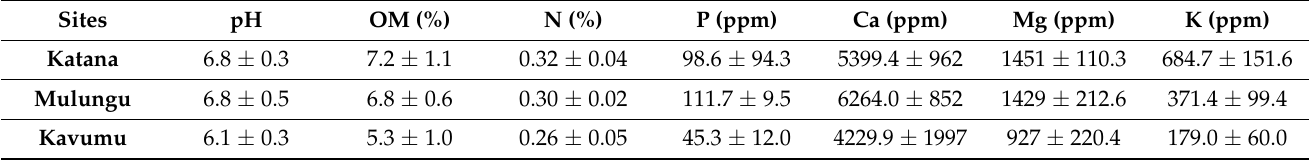
Table 1. Soil characteristics at Katana, Kavumu and INERA-Mulungu. For each site, soil pH, organic matter (OM), nitrogen content (N), phosphorus content (P) and calcium (Ca), magnesium (Mg) and potassium (K) are presented. The soil data presents average values of samples collected at the onset of the trials in 2014 and at the end of the trials in 2018. Sites pH OM (%) N (%) P (ppm) Ca (ppm) Mg (ppm) K (ppm)